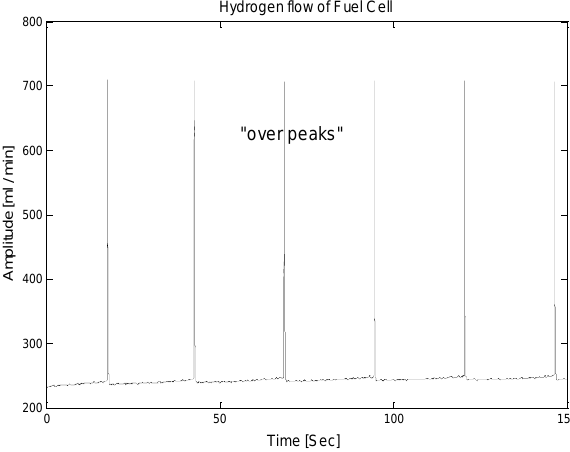
Figure 3: Measurement of the Hydrogen flow.